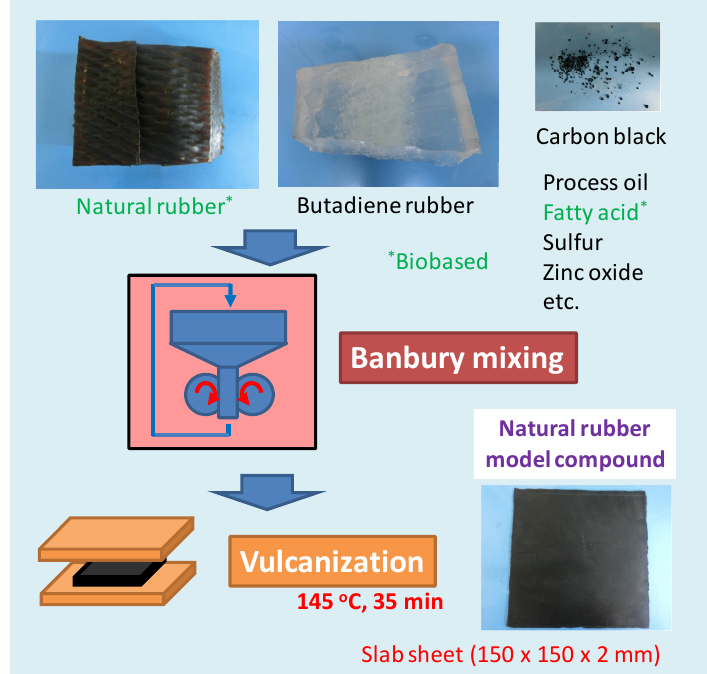
Figure 3. Production of natural rubber model